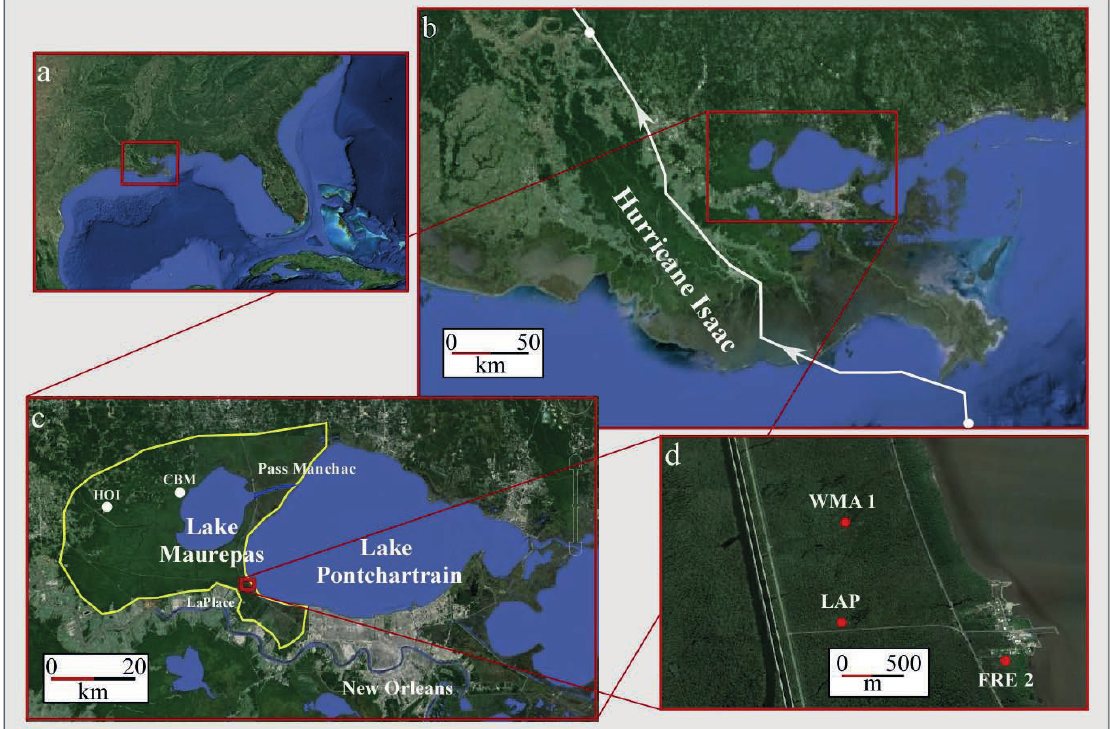
Fig. 1 Location of the study site. Google Earth imagery displays the location of: (a) the northern Gulf of Mexico, (b), southeastern Louisiana, (c), the western margin of Lake Pontchartrain, (d) the locations of cores WMA 1, LAP and FRE 2. The two white dots marked on the storm track in (b) show the forward movement of Hurricane Isaac during a 36 hour